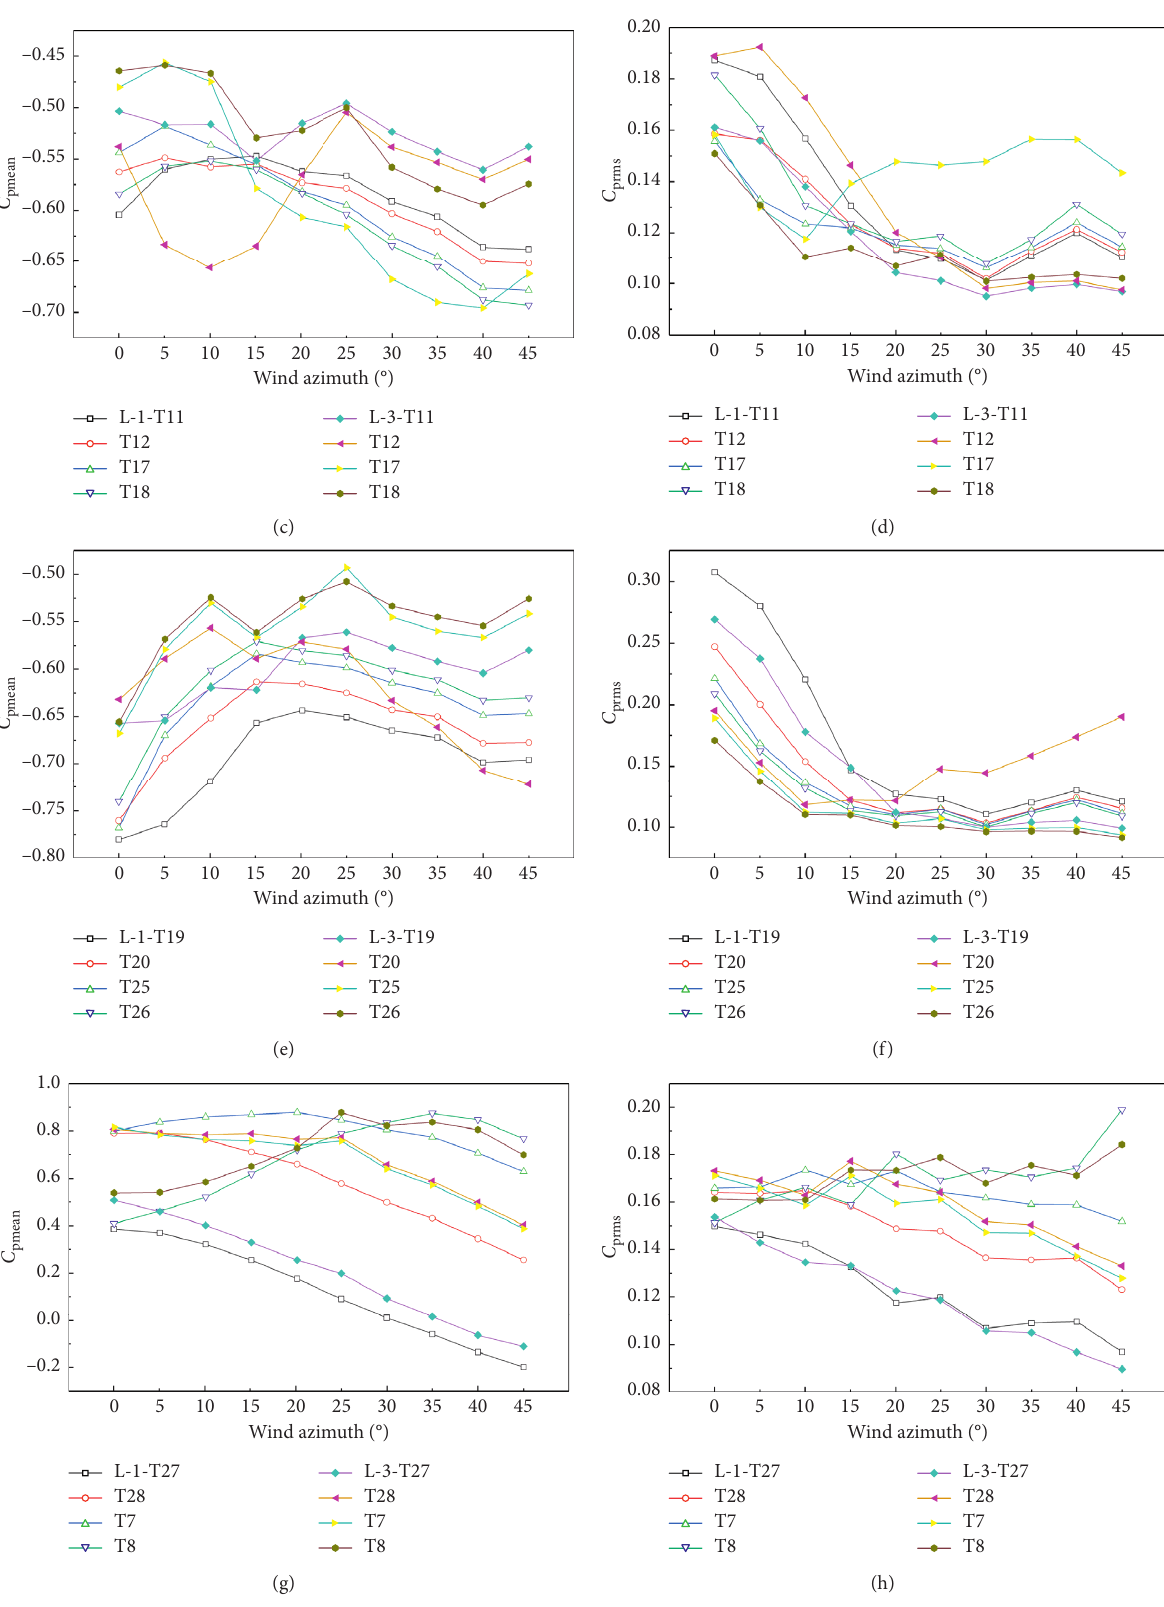
Figure 22: The variation of the mean and the fluctuating pressure coefficients of the T layer in the models of L-1 and L-3 with the wind direction. (a) Mean pressure coefficients (T1, T2, T9, and T10). (b) Fluctuating pressure coefficients (T1, T2, T9, and T10). (c) Mean pressure coefficients (T11, T12, T17, and T18). (d) Fluctuating pressure coefficients (T11, T12, T17, and T18). (e) Mean pressure coefficients (T19, T20, T25, and T26). (f) Fluctuating pressure coefficients (T19, T20, T25, and T26). (g) Mean pressure coefficients (T27, T28, T7, and T8). (h) Fluctuating pressure coefficients (T27, T28, T7, and